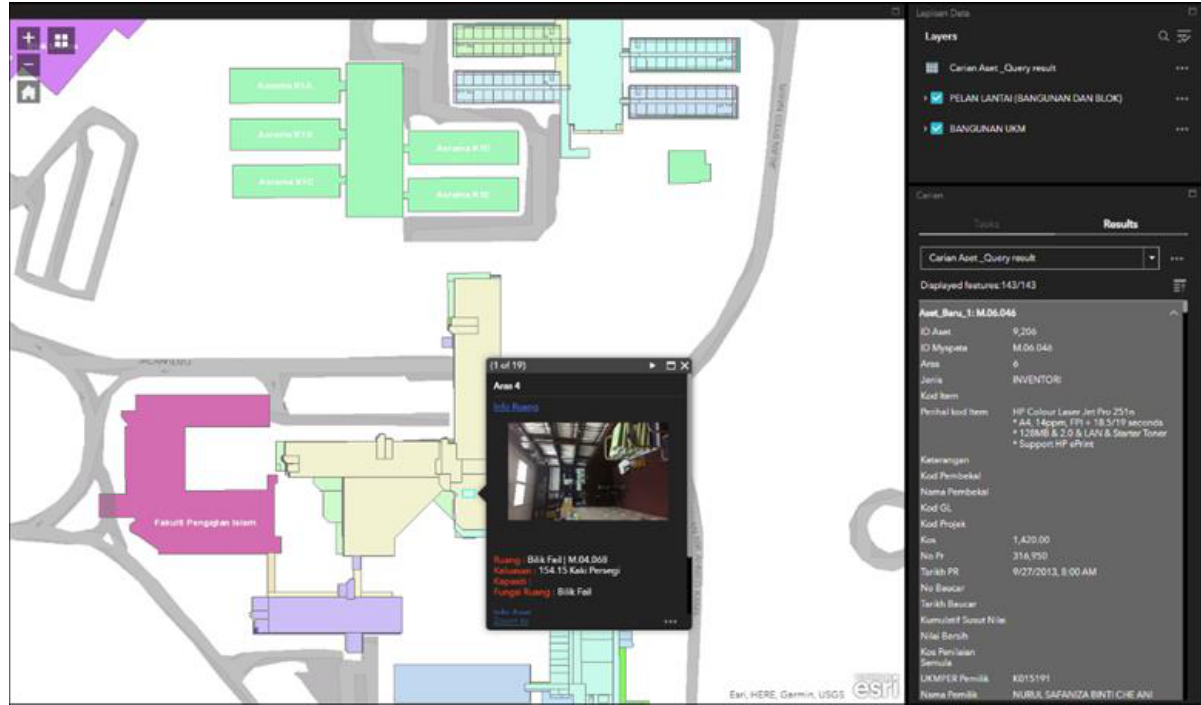
Figure 18. Example of query/searching in UKM FM